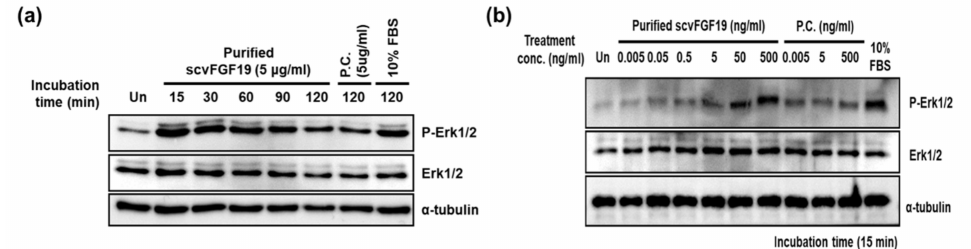
Figure 6. Biological activity of purified codon variant 19: ( a ) Time course of ERK1 / 2 kinase activation in HepG2 cells treated with 5 µ g / mL of the codon variant 19. P.C.: positive control. ( b ) Dose-dependent ERK1 / 2 kinase activation in HepG2 cells treated with the defined amount of recombinant scvFGF19 (codon variant 19) for 15 min. All experiments were conducted at least three times according to the described procedure in the methods